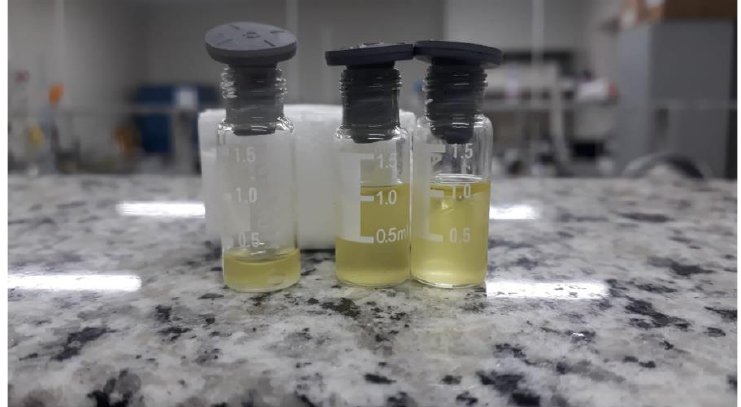
Figure 8. Production of the EOCC using the hydrodistillation